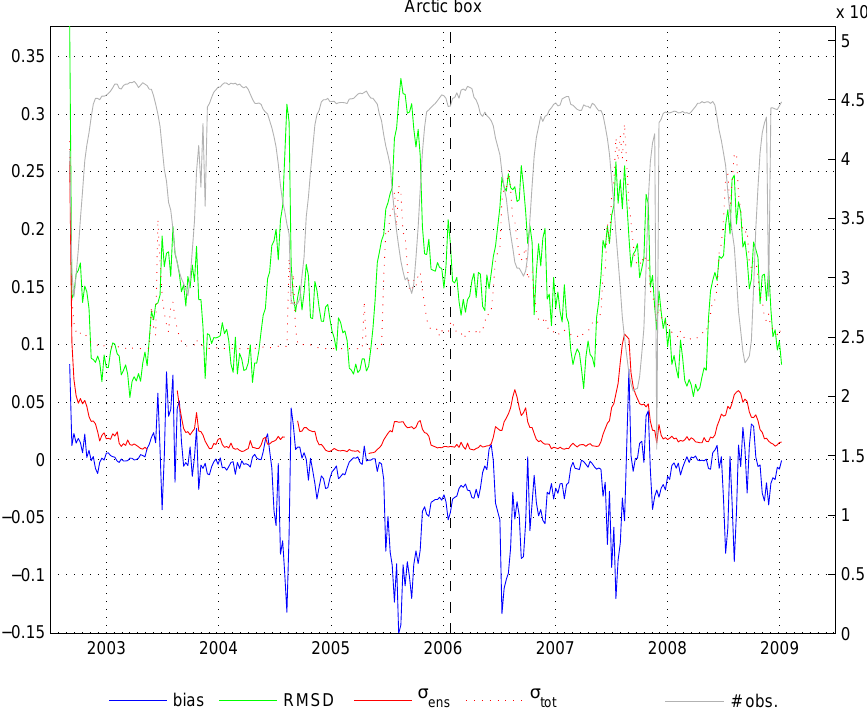
Fig. 7. Innovation statistics for ICEC (see description in caption to Fig. 5).